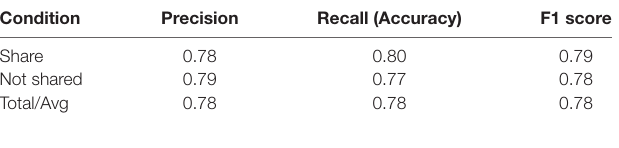
TABLE 1 | Classification results using only pleasantness ratings (self-reported variable).